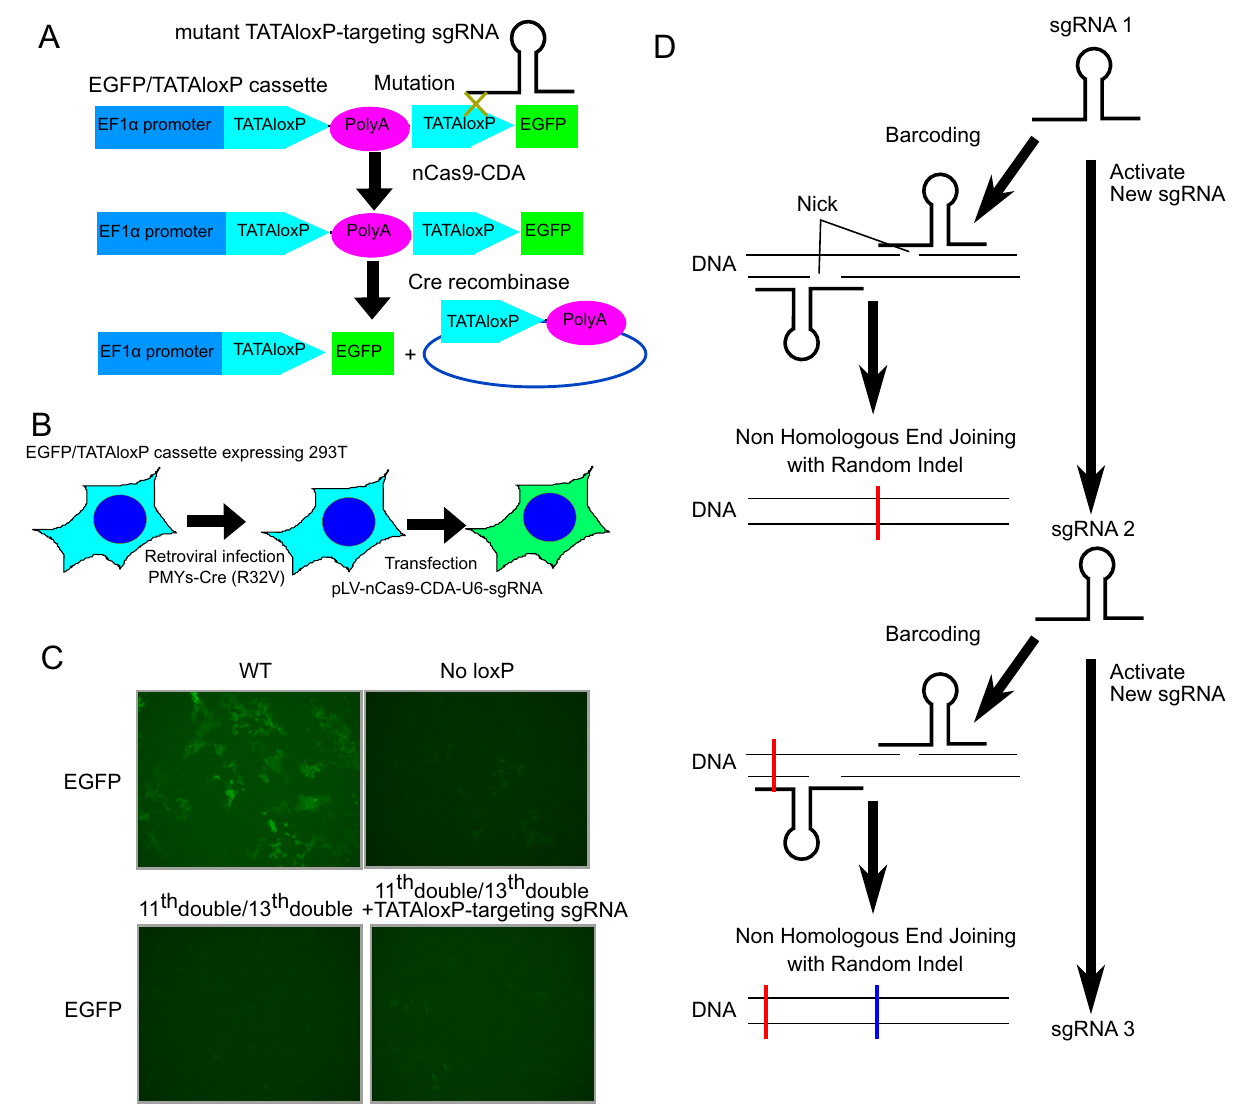
Figure 7. Cellular chain reaction systems through sequential repair of loxP mutations. ( A ) Schematic representation of the chain reaction by repair of TATAloxP mutations to express EGFP in 293 T cells. ( B ) Experimental scheme used in ( C ). 293 T cells were transduced with the EGFP/different TATAloxP cassette with the indicated T > C mutations, then infected with Cre-R32V, and then transfected with nCas9-CDA and sgRNA targeting the T > C mutation. ( C ) Fluorescence images of 293 T cells expressing EGFP/TATAloxP cassette, Cre- R32V, and nCas9-CDA along with the indicated sgRNAs. When the EGFP/TATAloxP cassette was used with T > C mutations at the 11th and 13th bases in both arms, no EGFP expression was detected, even in the presence of the TATAloxP-targeting sgRNA (bottom right). ( D ) Schematic representation of barcoding